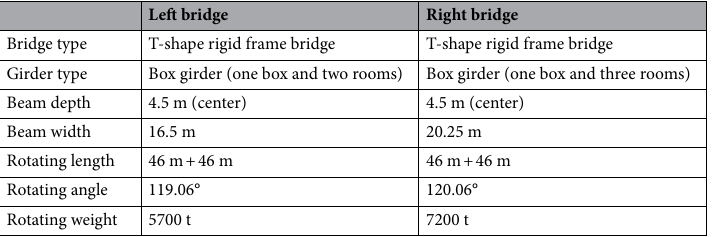
Table 1. Geometric specification of two